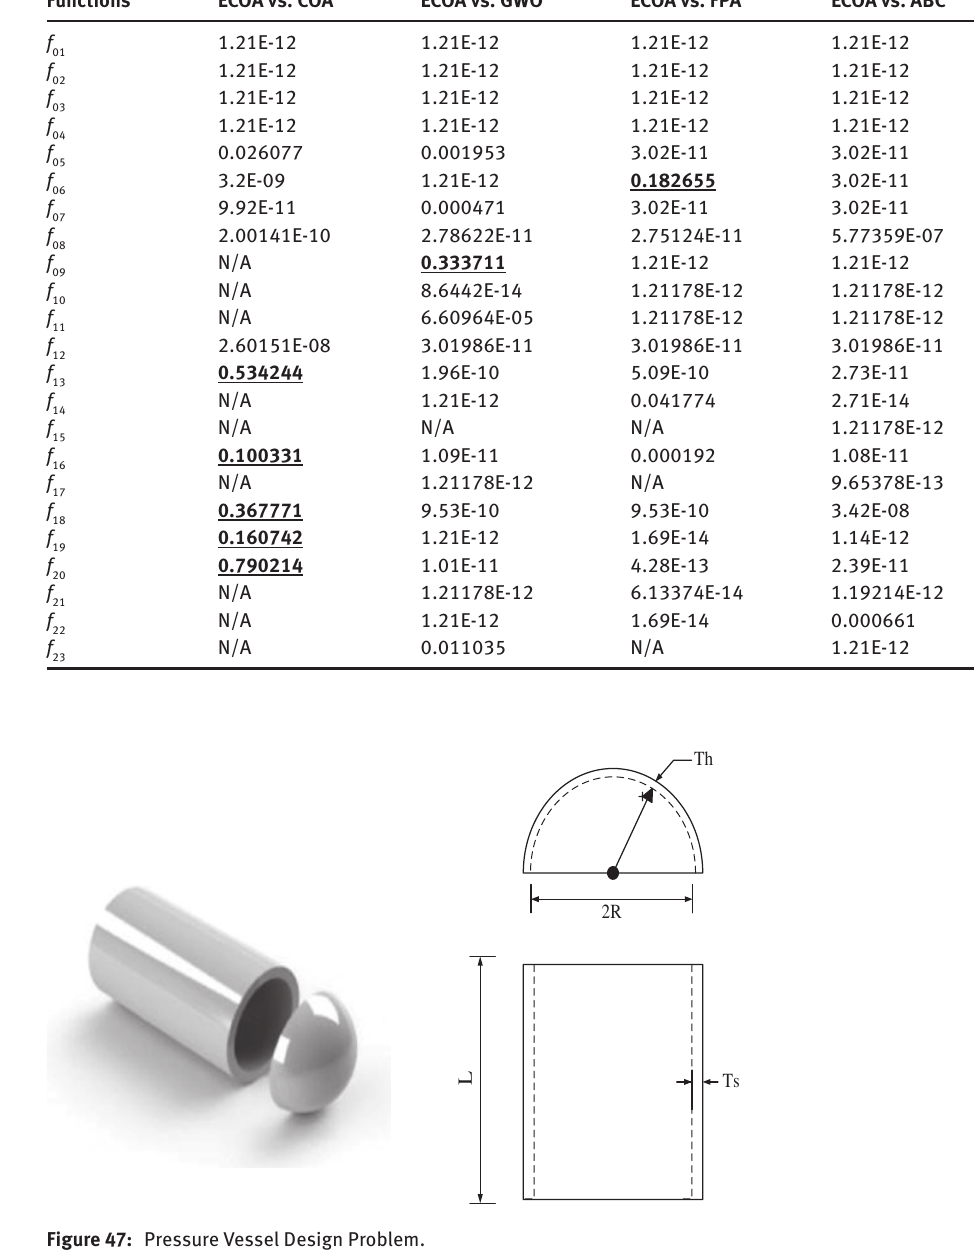
Table 5: p -Values of the Wilcoxon Rank-Sum Test Results. Functions